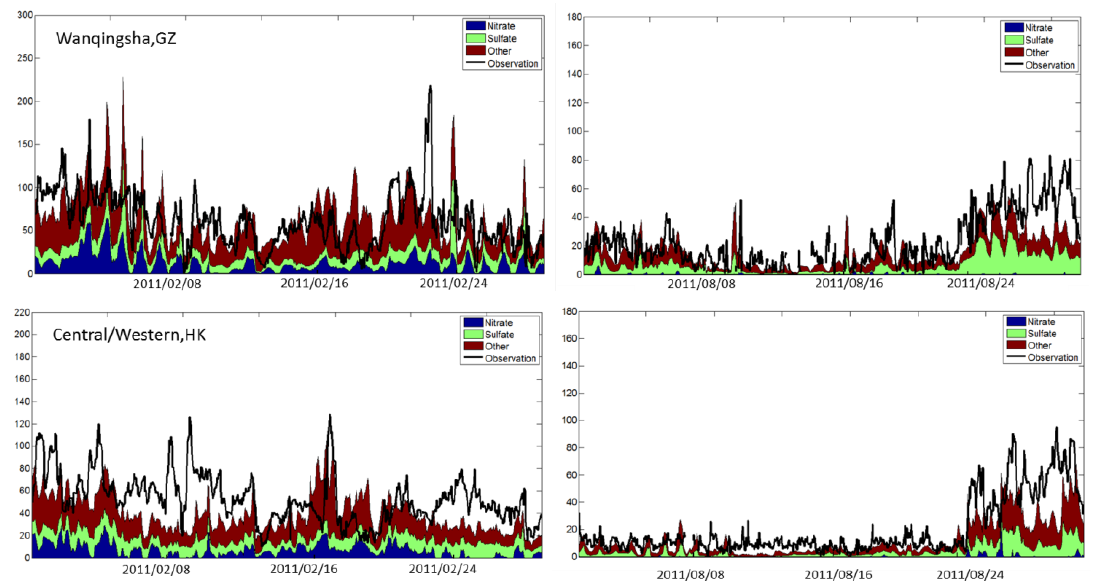
Figure 4. Model and observation comparison for two stations in the PRD region.